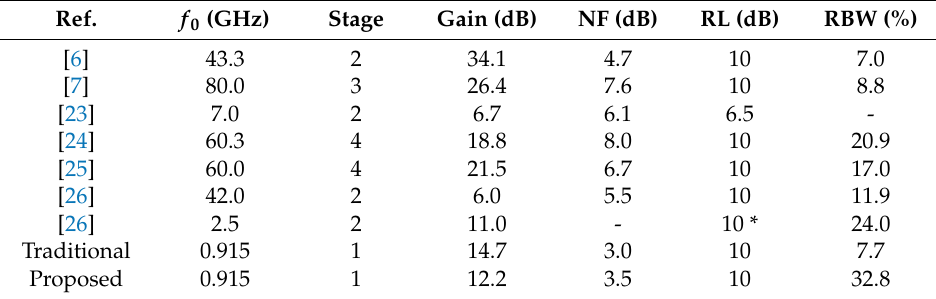
Table 2. Performance